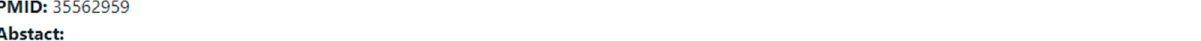
Figure 9. NER result screen on web page after PMID input. (a) It is an interface to indicate the type and color of the result category from the NER. At this point, we implemented RE, which classifies and correlates the relationship of named entities based on entity type, rather than just performing NER. We used Net- workX, a graph library that analyzes data and graphically expresses relationships within data, to visualize RE, and Cytoscape, a visualizing library that allows the model created in this manner to be more flexible on a web page, to implement RE. Figure 10 illustrates the correlation between words in a text using the aforemen-tioned RE process. Figure 10. RE result screen on web page after PMID input. 5. Discussion There is a BERN web service that extracts and displays new entities for biological domain text. In contrast, this paper enables users to see the relationship between new ob- jects at a glance by performing RE tasks in addition to simply NER. Because we perform sentence-level relationship extraction several times, our RE work requires a relatively